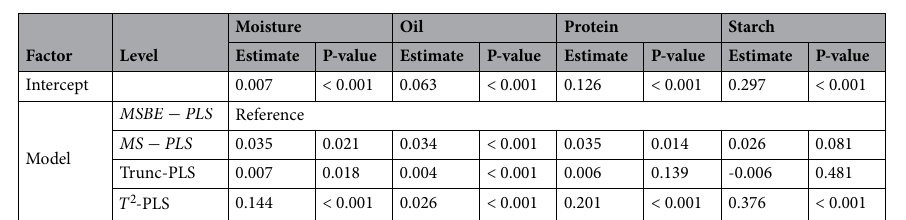
Table 1. The ANOVA results indicating the significant PLS model against each corn characteristic moisture, oil, protein, and starch are presented.